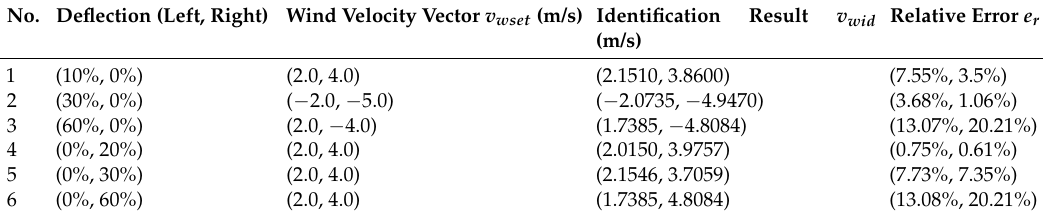
Table 2. Simulation settings and wind field identification results.